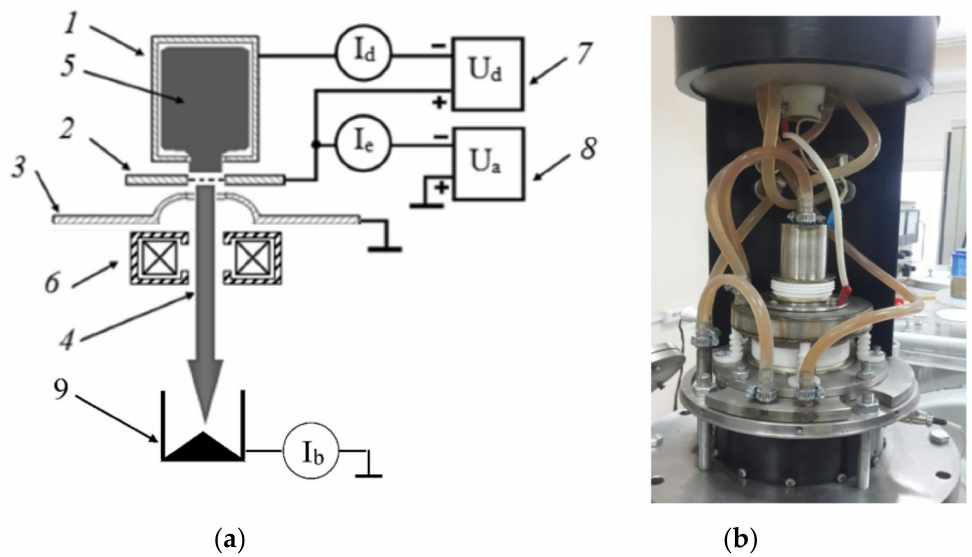
Figure 1. ( a ) Electrode circuit, and ( b ) photograph of the fore-vacuum plasma electron source: 1—water-cooled hollow cathode, 2—anode with emission grid, 3—accelerating electrode (extractor), 4—cylindrical electron beam, 5—emission plasma, 6—focusing system, 7—discharge power source, 8—accelerating voltage source,